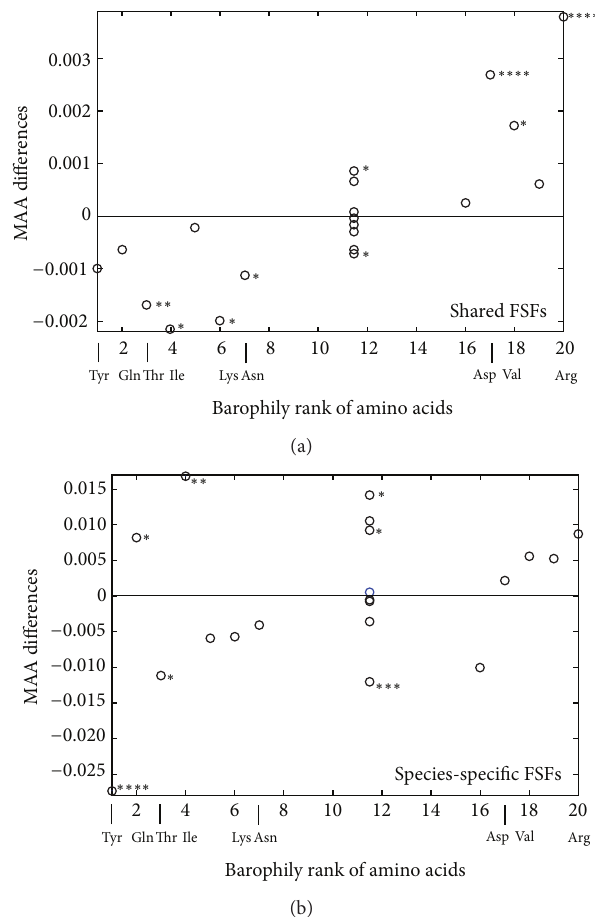
Figure 5: MAA analysis of shared FSF domains. (a) Although Tyr and Gln were used significantly more by P. furiosus in entire sequences, their use within the shared FSF domains seems to be statistically the same between the two Pyrococci . (b) Amino acids do not follow their patterns of homologous substitution within the species-specific FSFs. Statistical significance is marked with stars as described in Figure 2. A total of 1,627 P. abyssi and 1,739 P. furiosus sequences were analyzed.